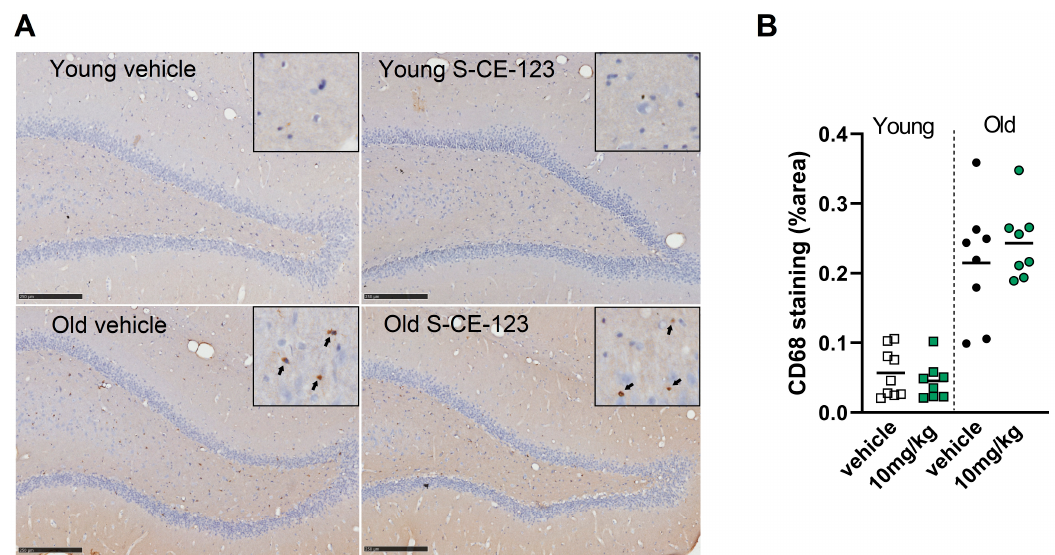
Figure 5. ( A ) Representative images of CD68 immunostaining in DG hippocampal subregion (scale bars represent 250 µ m). ( B ) Quantification of CD68 immunostaining in the DG of young and aged rats treated with 10 mg/kg S-CE-123 or vehicle. Each dot represents the mean of values across the three sections in an individual animal. Values are expressed as mean ±